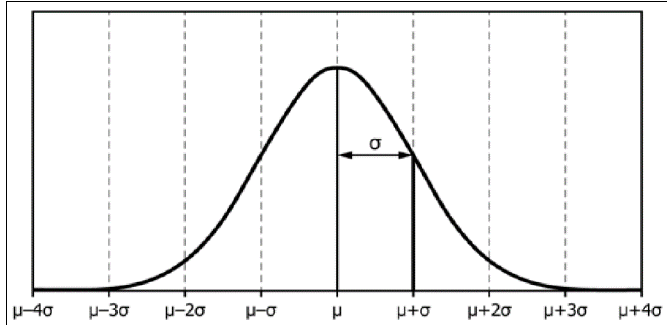
Figure 2: Normal Distribution and Relationship to Parameters μ ( ) representing the “center” and σ (s) representing the “spread”.